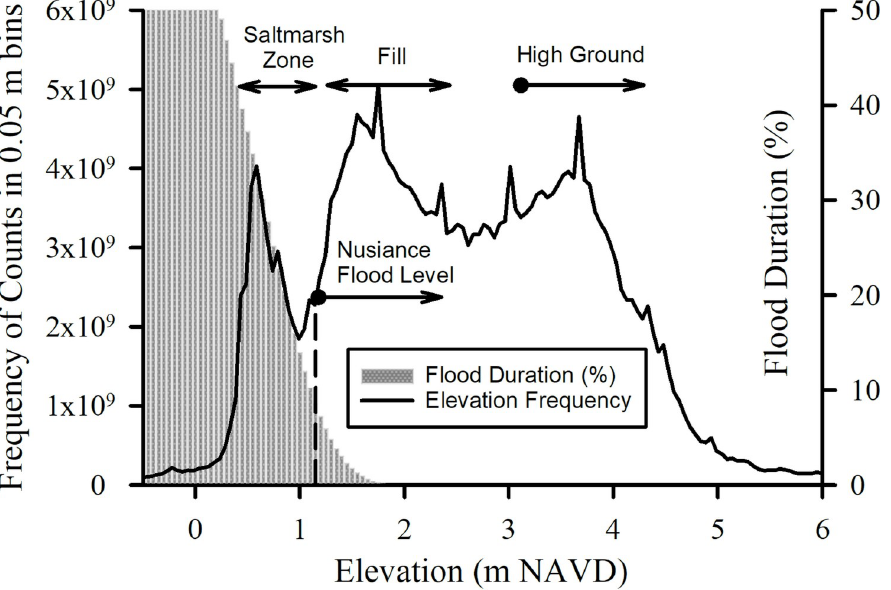
Fig 6. Frequency distribution of surface elevation. Frequency distribution of Charleston peninsula elevations in 0.05 m bin classes and the exponential model forecast of flood duration (% of time flooded) during years 2064–2068 as a function of